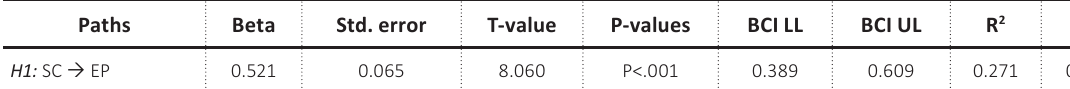
Table 6. Structural path analysis: direct effects